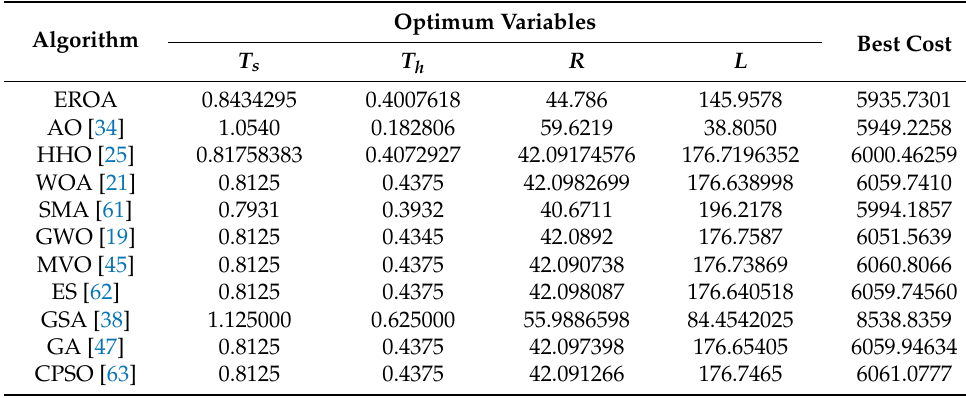
Figure 7. The pressure vessel design problem is the 3D model diagram ( left ) and structural parameters ( right ). Table 9. Optimization results for the pressure vessel design